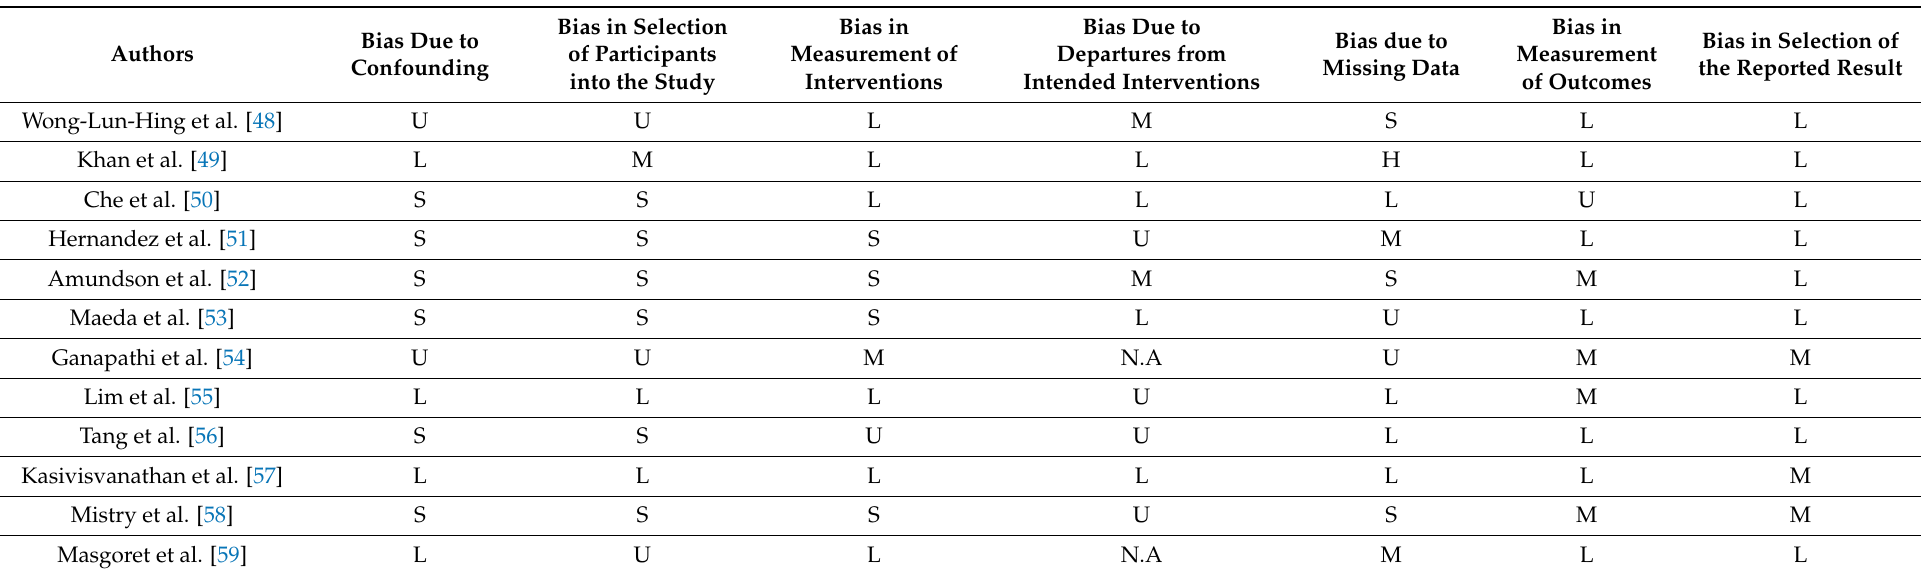
Table 2. Risk of bias for the non-randomized controlled trials